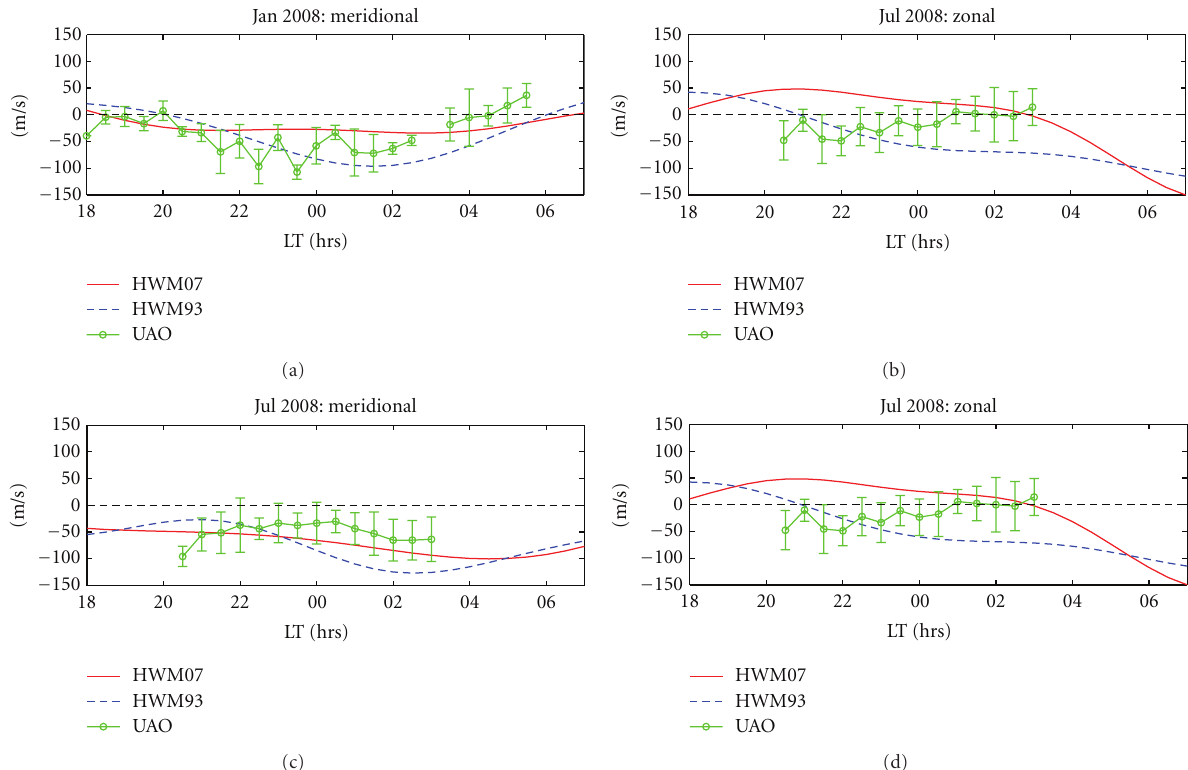
Figure 1: Comparison of monthly-averaged thermospheric neutral winds measured over the Urbana Atmospheric Observatory (40.10 N, − 88.23 E) Illinois and the results of the HWM93 [11] and HWM07 climatological